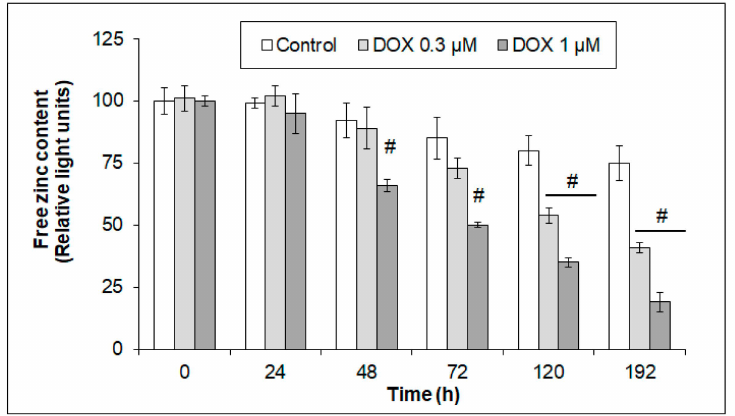
Figure 4. Effects of 0.3 µ M and 1 µ M DOX on intracellular free Zn levels in hiPCS-CMs during 192 h. Free zinc content in control and DOX-treated cells was measured by microfluorometry of the zinc-specific dye Newport Green diacetate, as described in Section 4. Values represent means ± SD of N = 4 experiments. # p < 0.05 compared to untreated control cells at the same treatment interval with one-way ANOVA test and Dunnett’s post test for multiple comparisons.